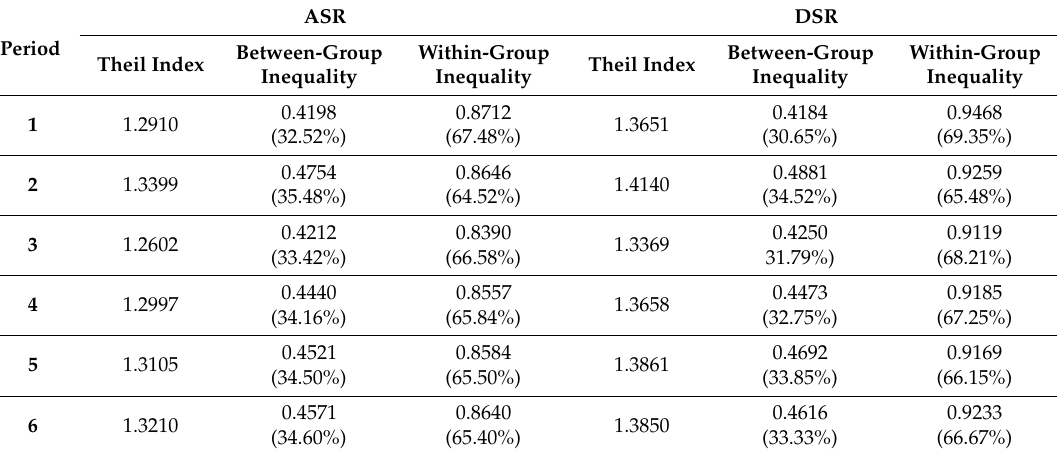
Table 6. The Theil index and its decomposition of the service rate on